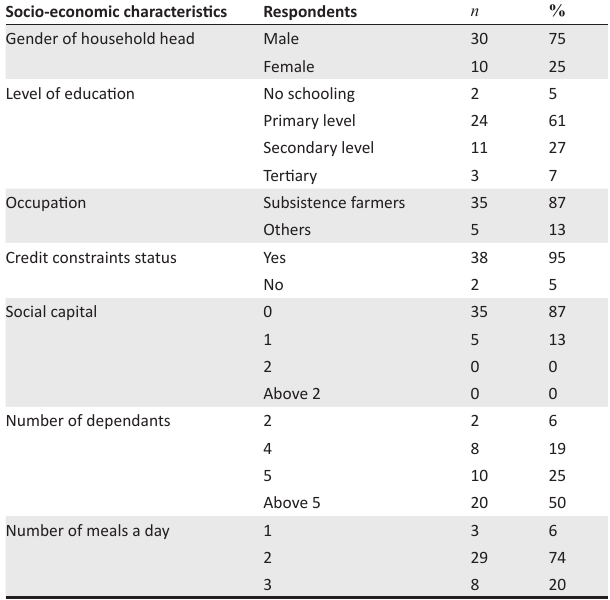
TABLE 2: Socio-economic characteristics of the